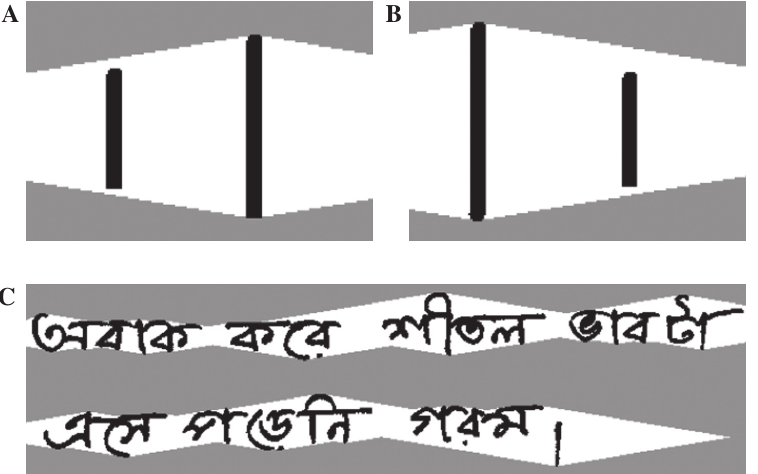
Figure 3. Common Wetted Area of Any Image Frame Under Hypothetical Bidirectional (Right-to-Left and Left-to-Right) Water Flow